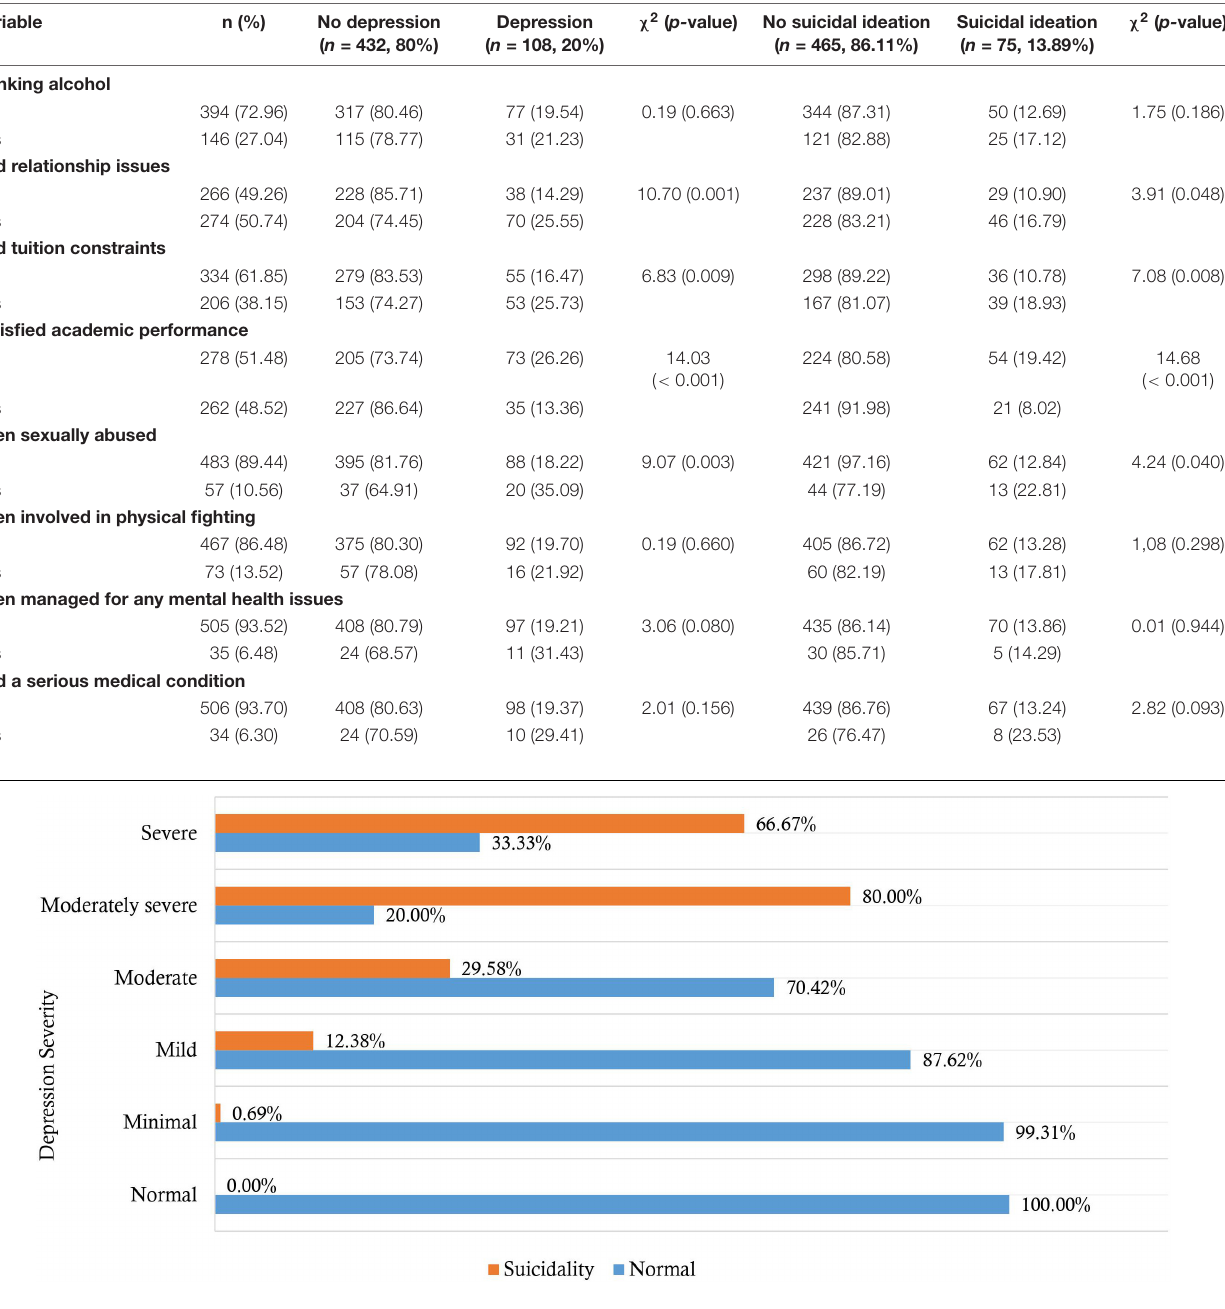
FIGURE 1 | Severity of depression and suicide ideation among Ugandan University students.